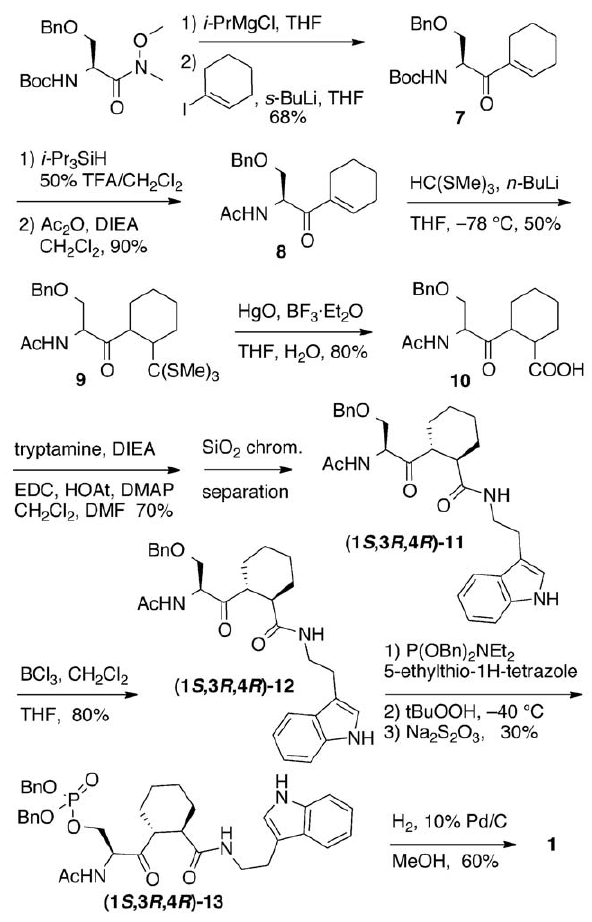
Figure 3. Cyclohexyl ketone inhibitor 1 was synthesized by the method shown.